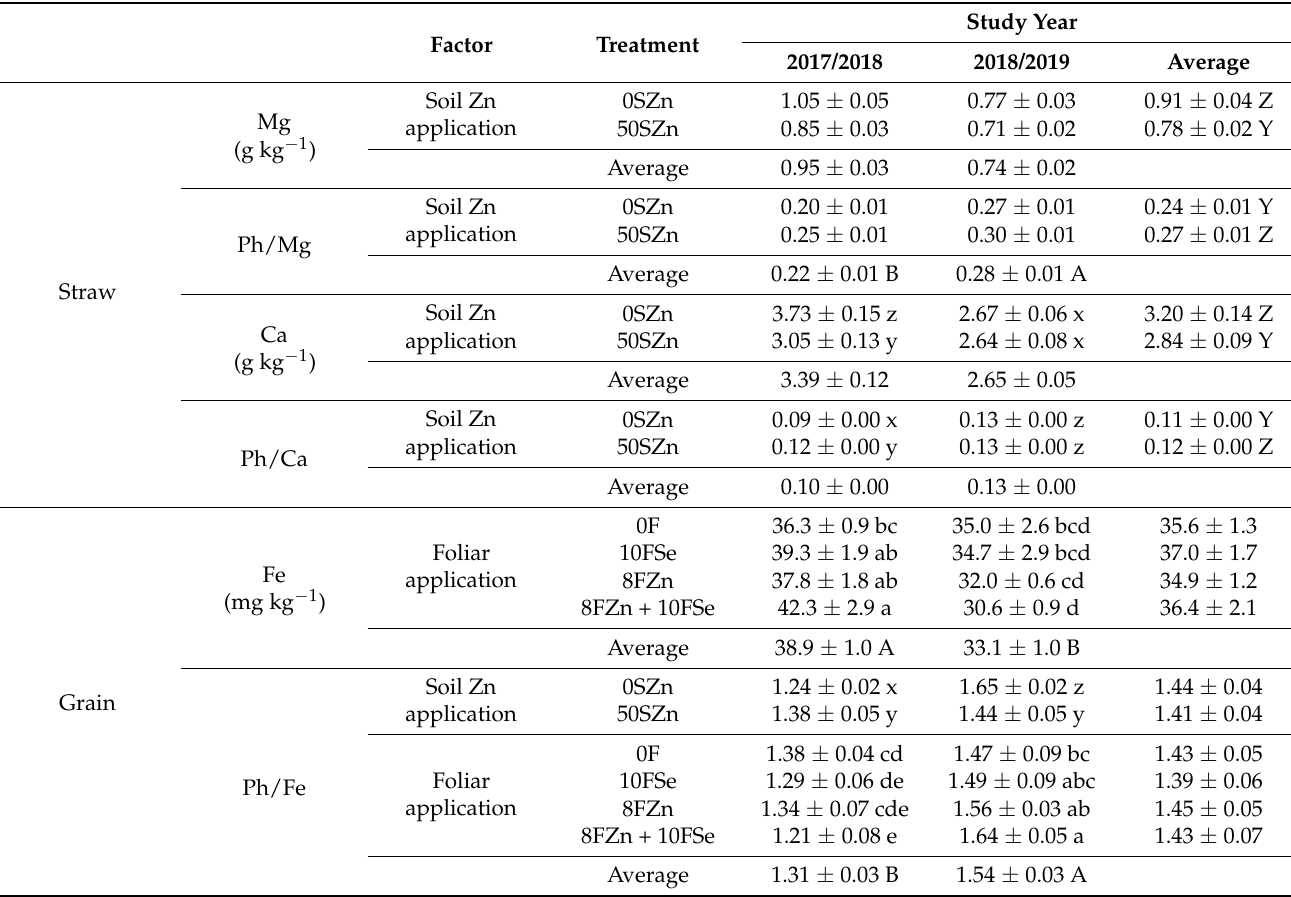
Table 3. Concentration of Mg, Ca and Fe, and their molar ratio phytate:mineral in either the straw or grain, expressed as mean value ± standard error ( n = 3 for straw and = 4 for grain) as affected by the main effects ‘Study year (Y)’, ‘Zn soil application (S)’ and/or ‘Foliar application (F)’ (in bold) and by the interactions ‘Y*S’ and/or